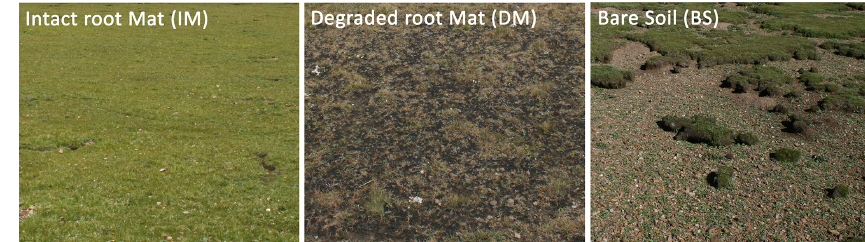
Figure 2. The three defined vegetation classes: (a) intact root Mat (IM); (b) degraded root Mat (DM); and (c) bare soil (BS).